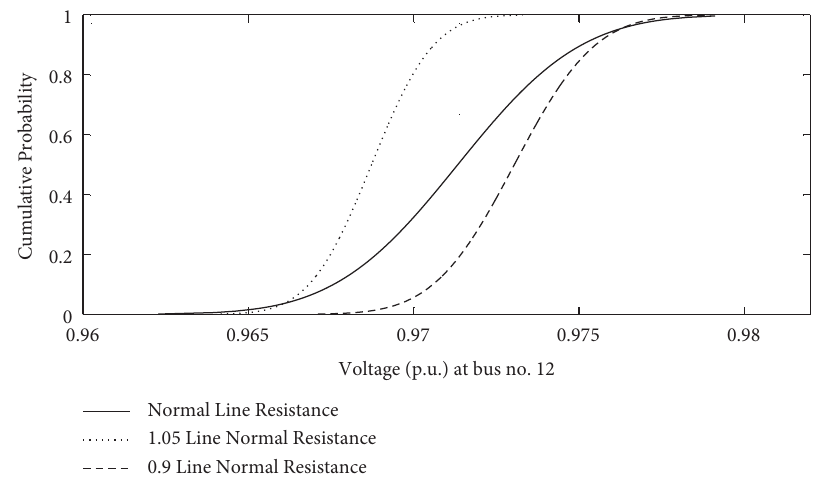
Figure 8: Distribution function of voltage at bus no. 12 for diferent values of line resistances.